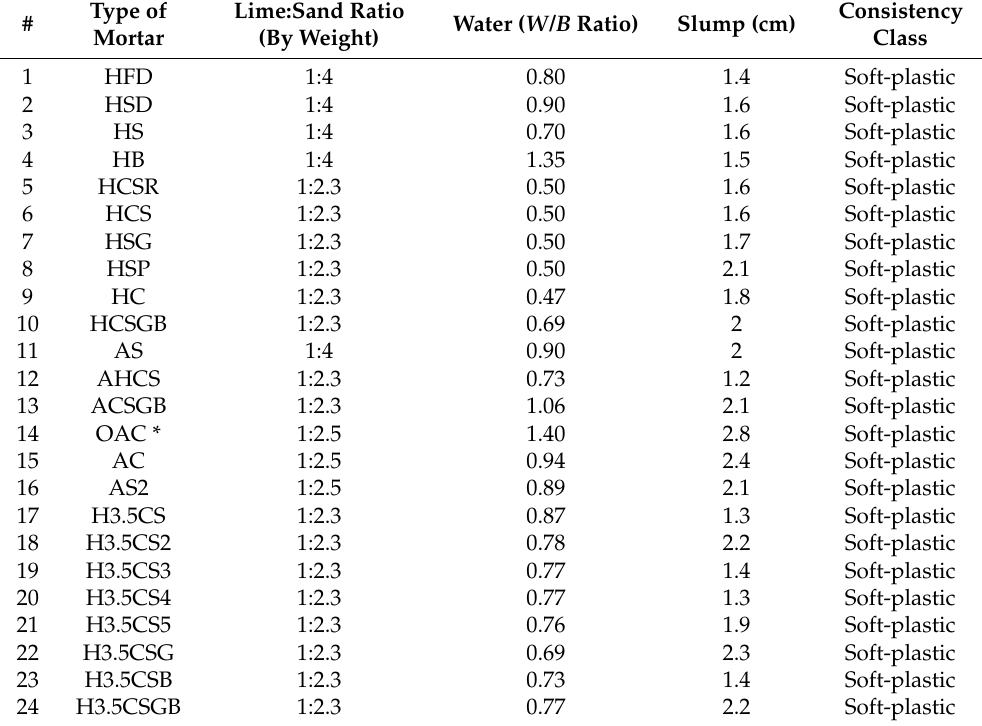
Table 2. Mixing water and consistency in restoration mortar formulations, W / B : water/binder ratio, i.e., water/lime